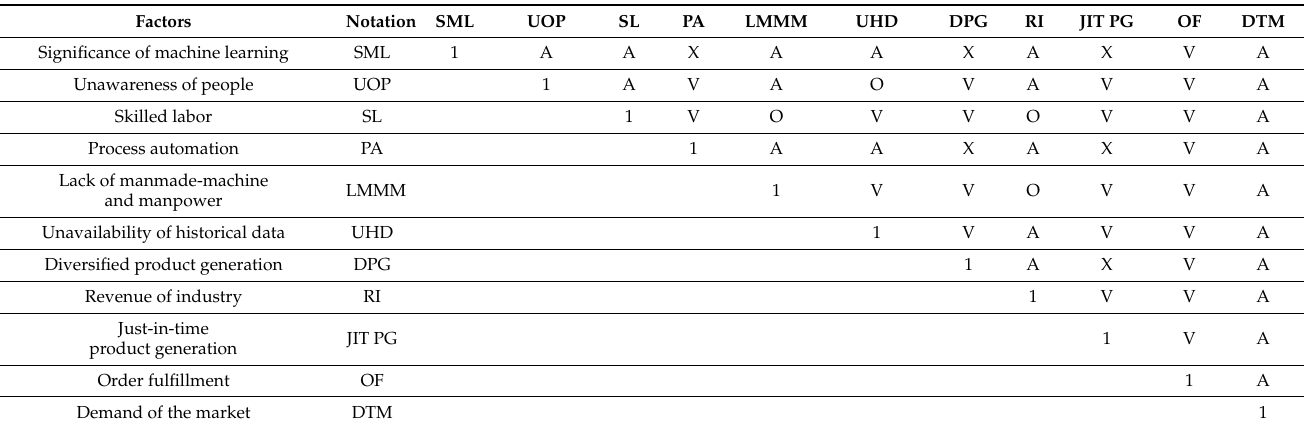
Table 2. SSIM matrix.